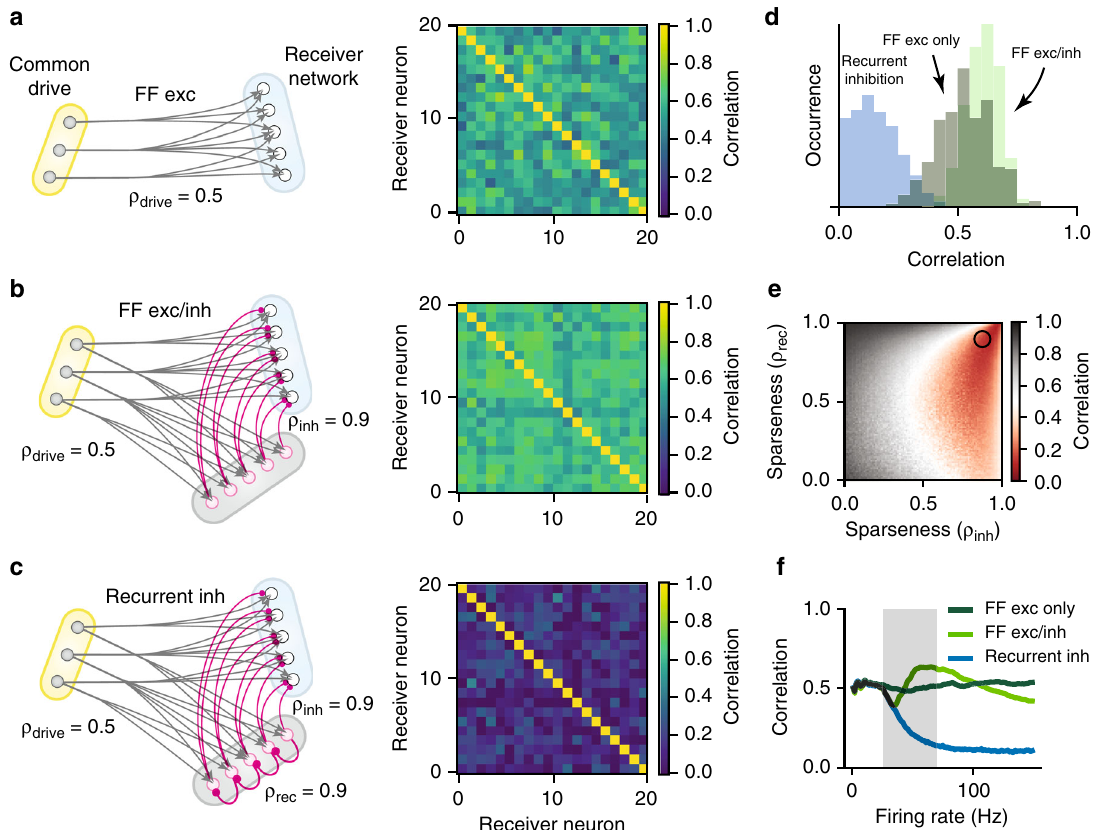
Fig. 9 Active decorrelation by local inhibitory network requires sparse recurrent inhibition. Considering 3 network motifs: a Common drive network (yellow) with pure feedforward excitation (FF exc) with low sparseness ( ρ drive = 0.5) and pairwise correlation of ~0.5 (pairwise correlation matrix, right). b Including feedforward inhibition (inh) via a local inhibitory network (gray) has a similar correlation matrix, i.e. no decorrelation (right). c The inclusion of recurrent inhibition causes decorrelation in the receiver population (blue matrix, right). d Histograms of pairwise correlations for the 3 motifs, where the recurrent inhibition (blue) causes lower correlation. e Decorrelation (red) depends on connection sparseness, both from inhibitory to receiver cells ( ρ inh ) and within the inhibitory population ( ρ rec ). Circle indicates sparseness of c . f Decorrelation depends on the fi ring rate of the source neurons (gray region), especially for the recurrent topology